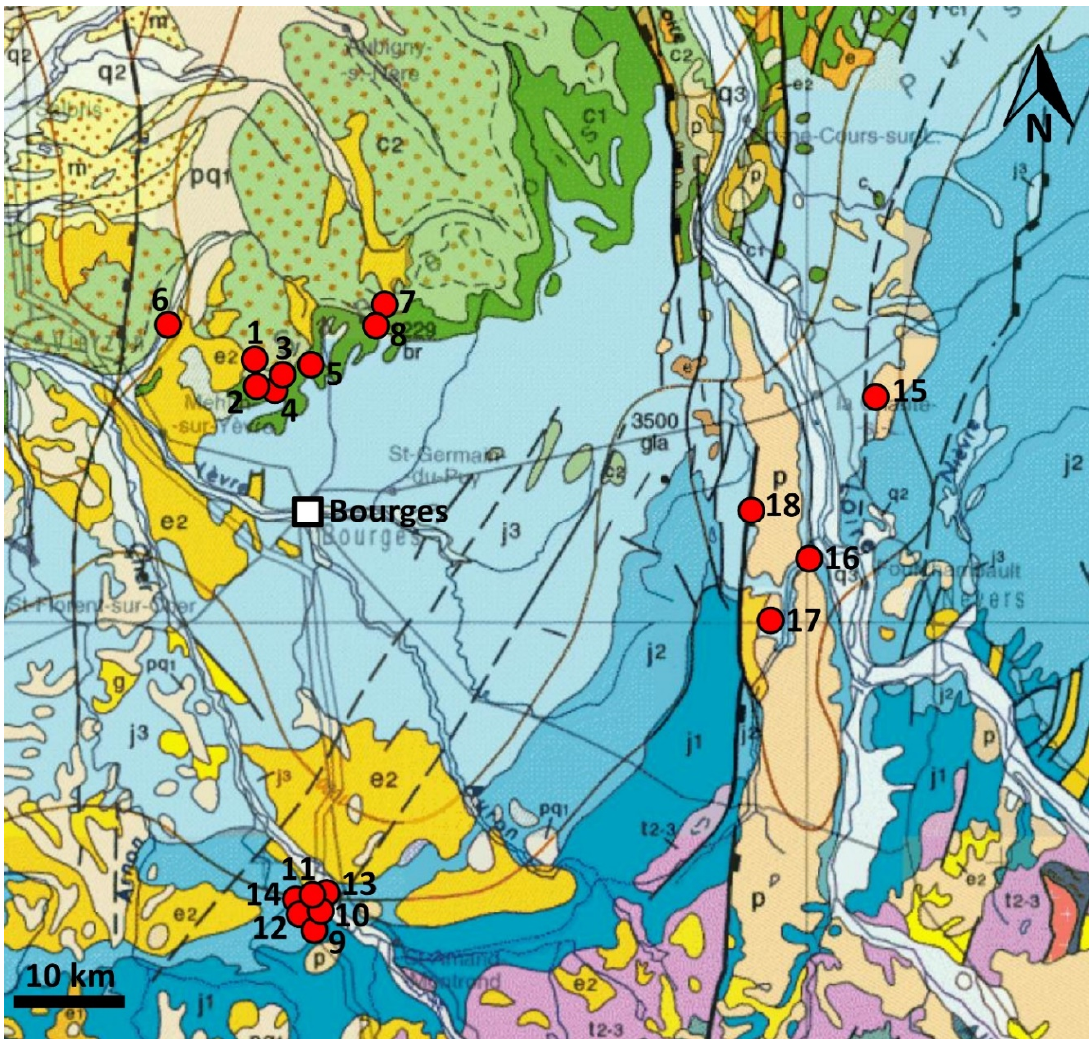
Figure 4. Location of the studied sites on a geological map.